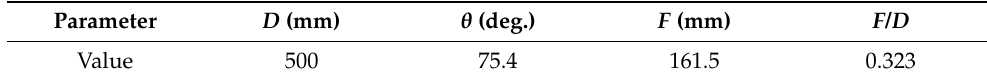
Table 3. Dimensions of the parabolic